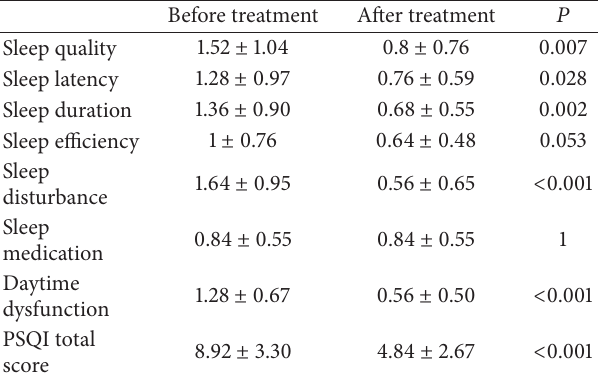
Table 1: PSQI total and subcomponents mean scores before and after